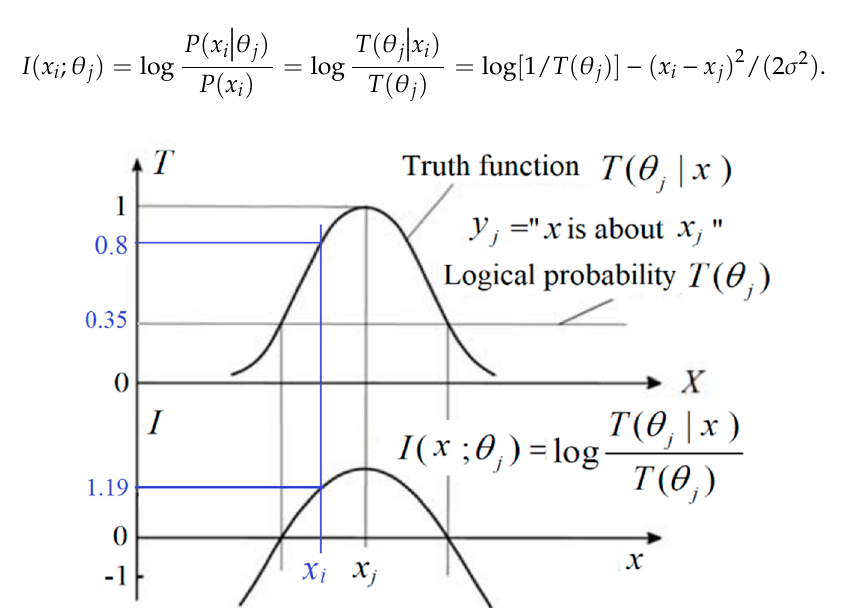
Figure 5. Semantic information conveyed by y j about x i can represent the verisimilitude of x j reflecting x i . When real x is x i , the truth value is T ( θ j | x i ) = 0.8; information I(x i ; θ j ) is log(0.8 / 0.35) = 1.19 bits. If x exceeds a certain range, the information is negative.